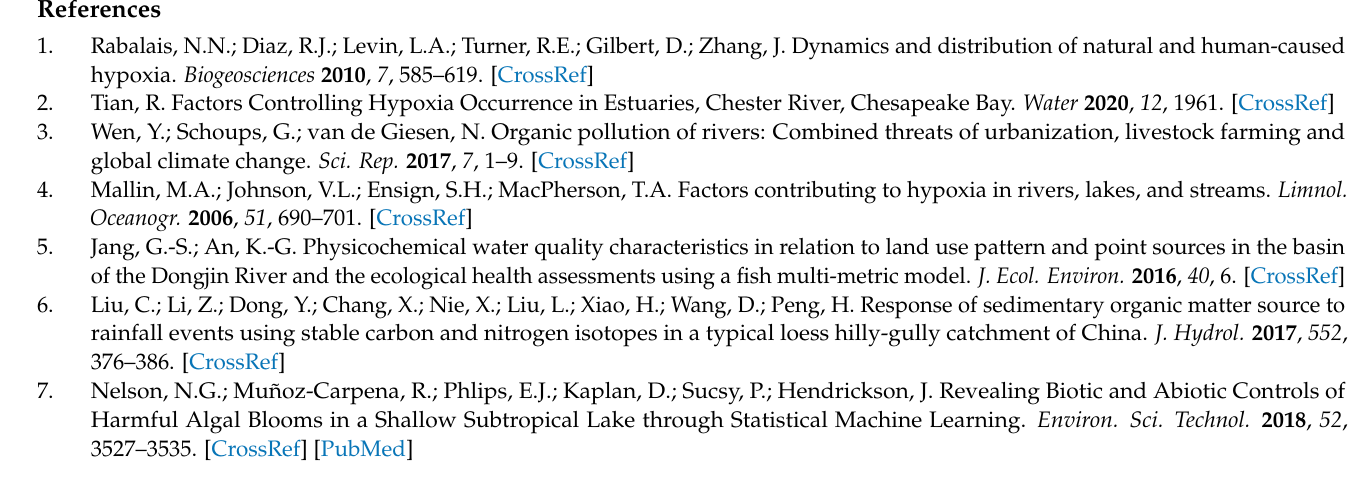
SI4 Figure S1 Kling Gupta Efficiency statistics (Sensitivity analysis) for Beaver land phase analysis; SI4 Figure S2 Kling Gupta Efficiency statistics (Sensitivity analysis) for Beaver aquatic phase analysis; SI4 Figure S3 Kling Gupta Efficiency statistics (Sensitivity analysis) for Trent River land phase analysis; SI4 Figure S4 Kling Gupta Efficiency statistics (Sensitivity analysis) for Trent River aquatic phase